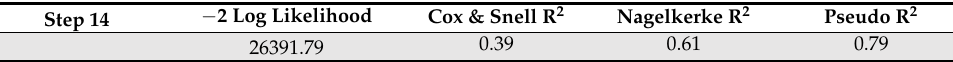
Table 6. Model summary statistics.